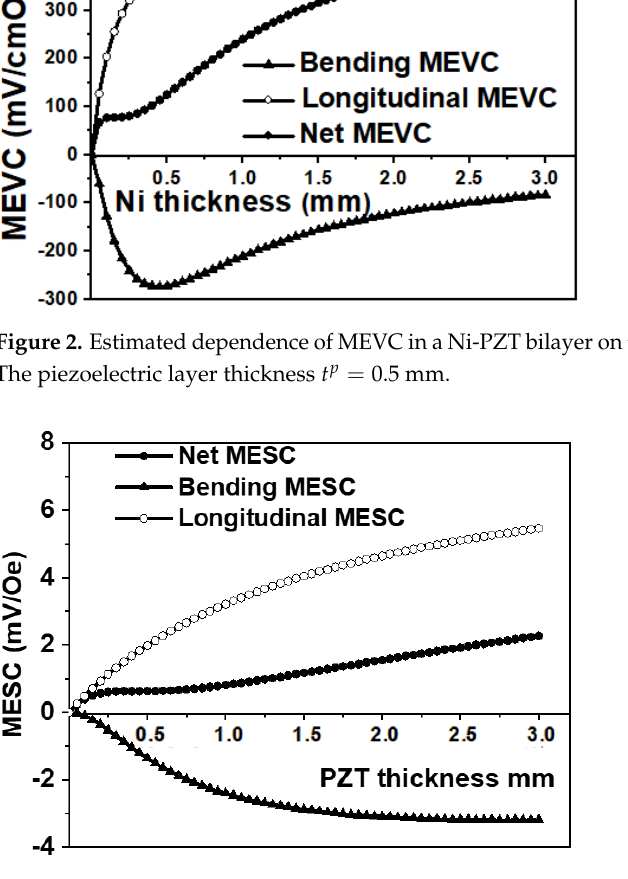
Figure 3. Dependence of MESC in a Ni-PZT bilayer on the piezoelectric layer thickness. The magnetostrictive layer thickness t m = 0.5 mm.